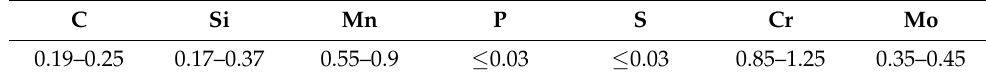
Table 3. Chemical composition of 20CrMnTi (wt%).